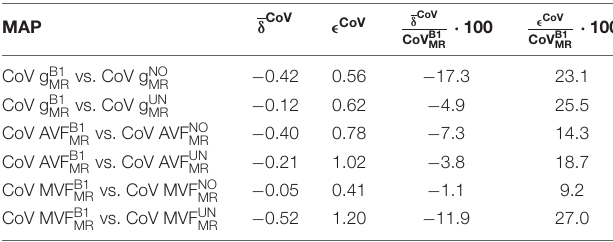
TABLE 5 | Bias and error between methods, in the CoV of g MR , AVF MR , and MVF MR .